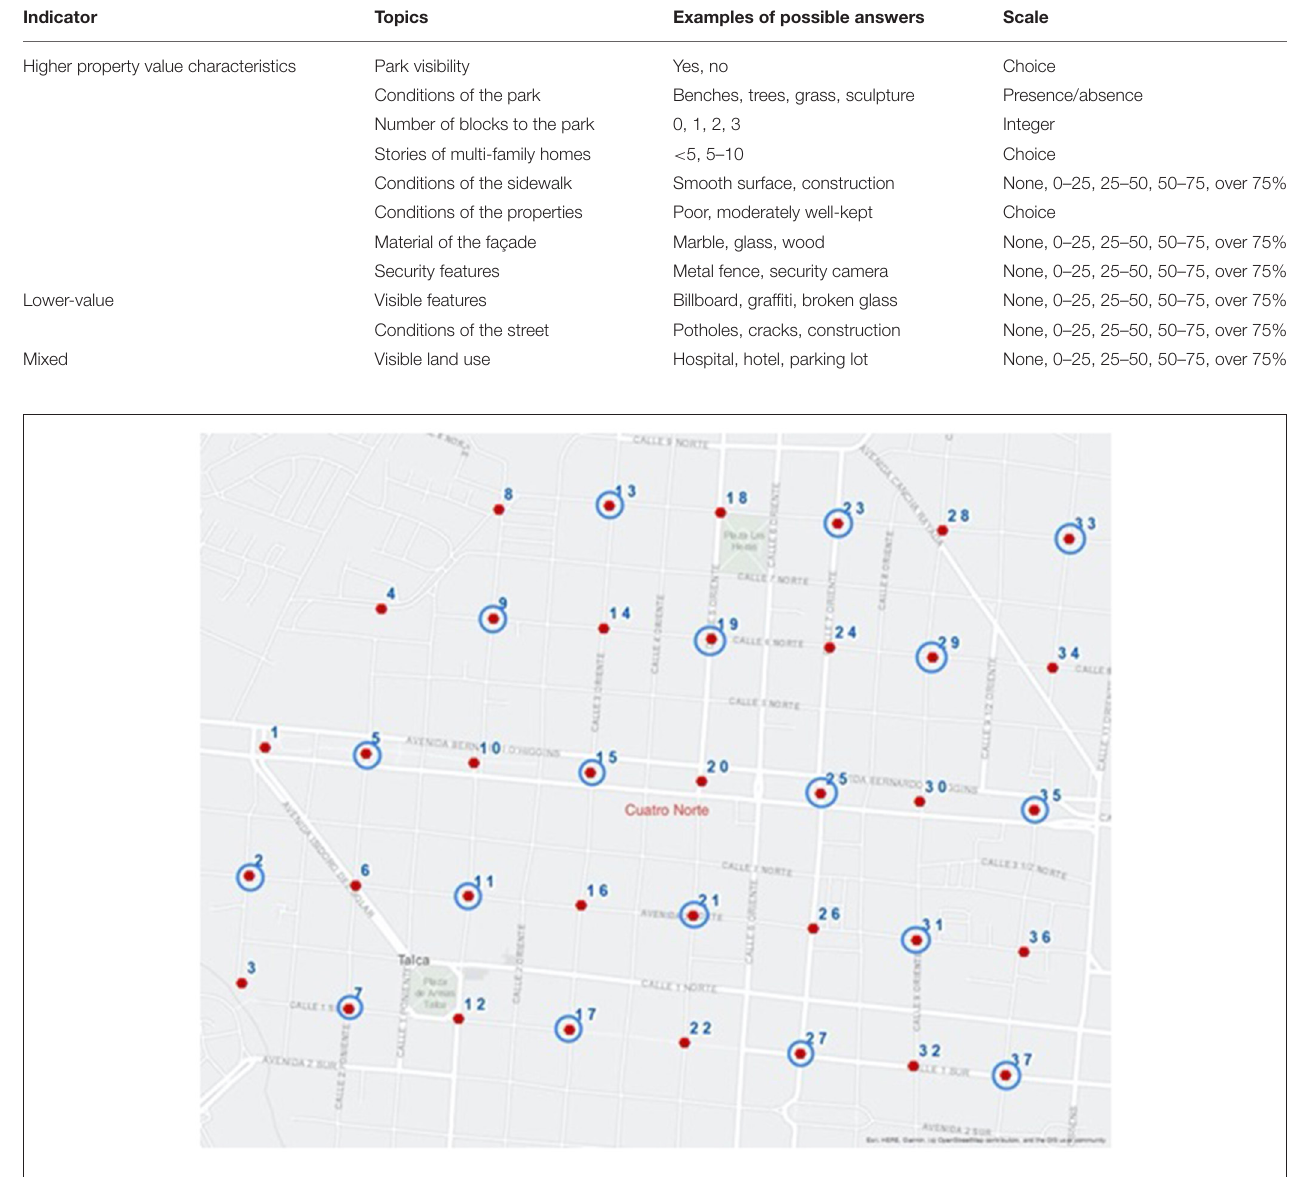
FIGURE 5 | Sampling locations surrounding Cuatro Norte,